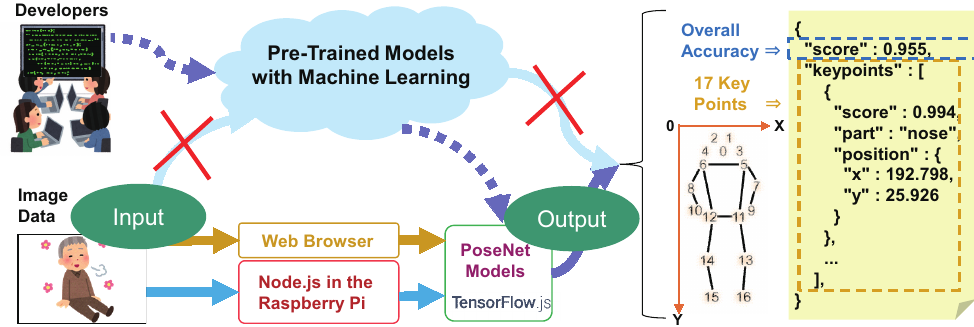
Figure 3. Overview of image-based bone sensing using PoseNet models on